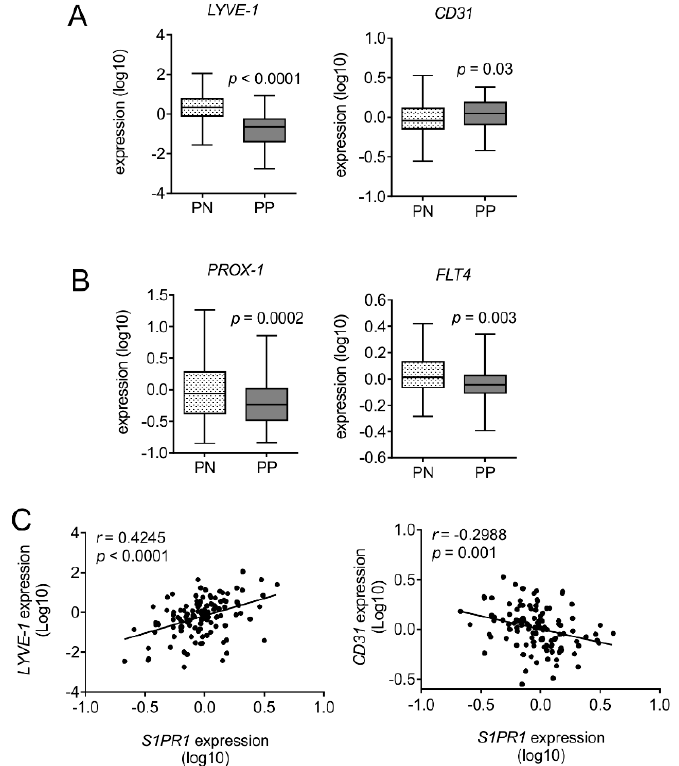
Figure 5. Reciprocal regulation of angiogenesis and lymphangiogenesis in human psoriatic patients. Gene expression data in Gene Expression Omnibus (GEO) dataset GSE13355 [23] were analyzed for ( A ) the expression of the lymphatic marker LYVE-1 and the blood endothelial cell marker CD31 as well as ( B ) the expression of the key lymphatic transcription factor PROX-1 and FLT4 (encoding VEGFR-3) in tissue with (PP) and without (PN) lesions from psoriatic patients. ( C ) The expression of LYVE-1 , CD31, and S1PR1 was analyzed to correlate the expression of S1PR1 with the lymphatic marker LYVE-1 and the blood endothelial cell marker CD31 . p values were calculated using two-tailed Student’s t -test, n =